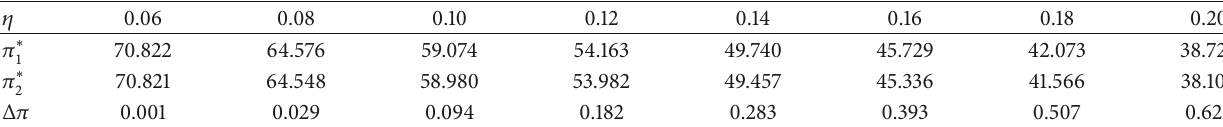
Table 2: Profit comparison under different 𝜂 .